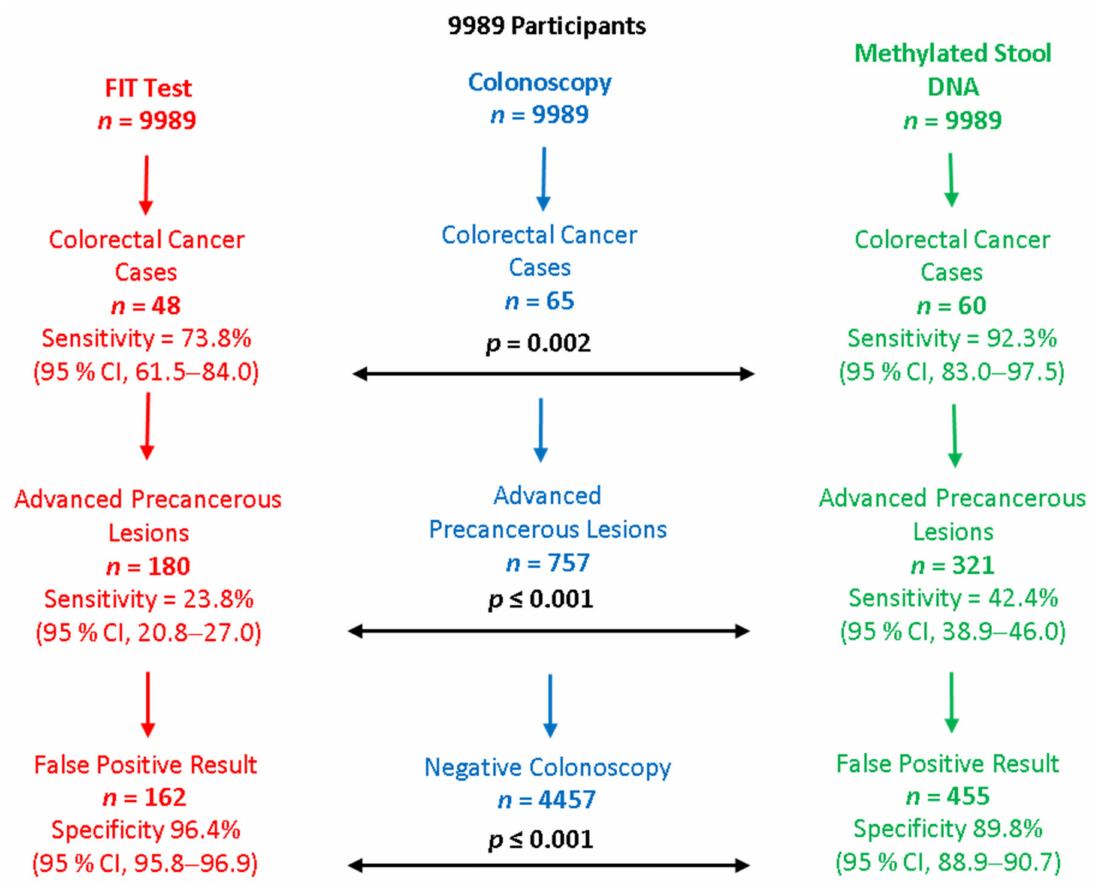
Figure 4. Summary of the main results of a study comparing FIT stool test to methylated DNA stool test for the detection of colorectal cancer